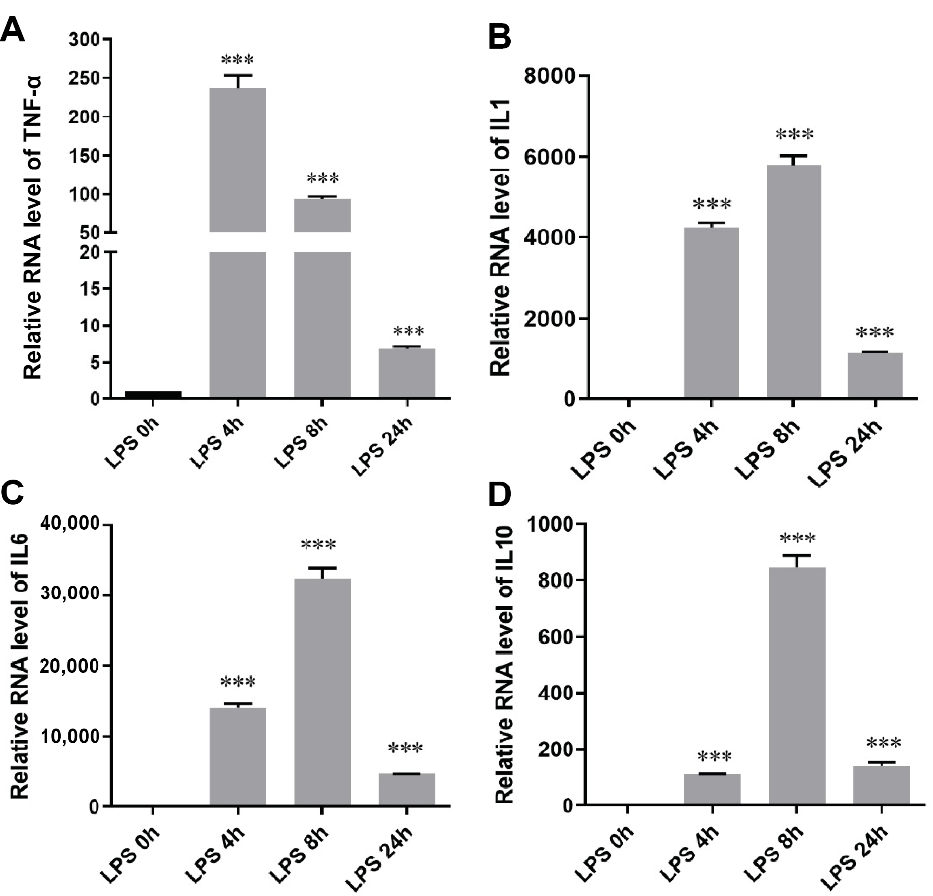
Figure 4. RNA expression levels of tumor necrosis factor- α (TNF- α ) ( A ), interleukin (IL)-1 β ( B ), IL-6 ( C ), and IL-10 ( D ) in RAW 264.7 macrophages exposed to 500 ng/mL lipopolysaccharide (LPS). Data are presented as mean ± standard error of mean (SEM) of three replicates. Statistics by ANOVA with Tukey’s multiple comparison post-hoc analysis. ***, p < 0.001.